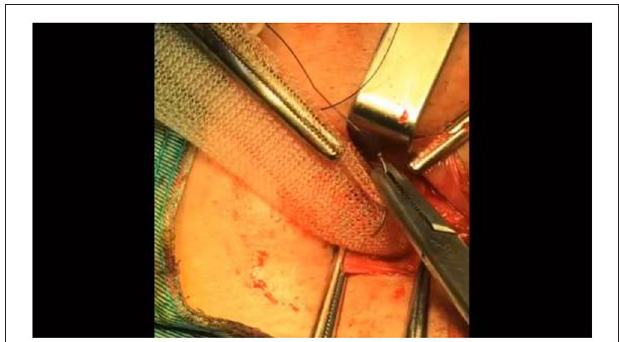
FIGURE 3 | Run the hook through the center of the mesh.